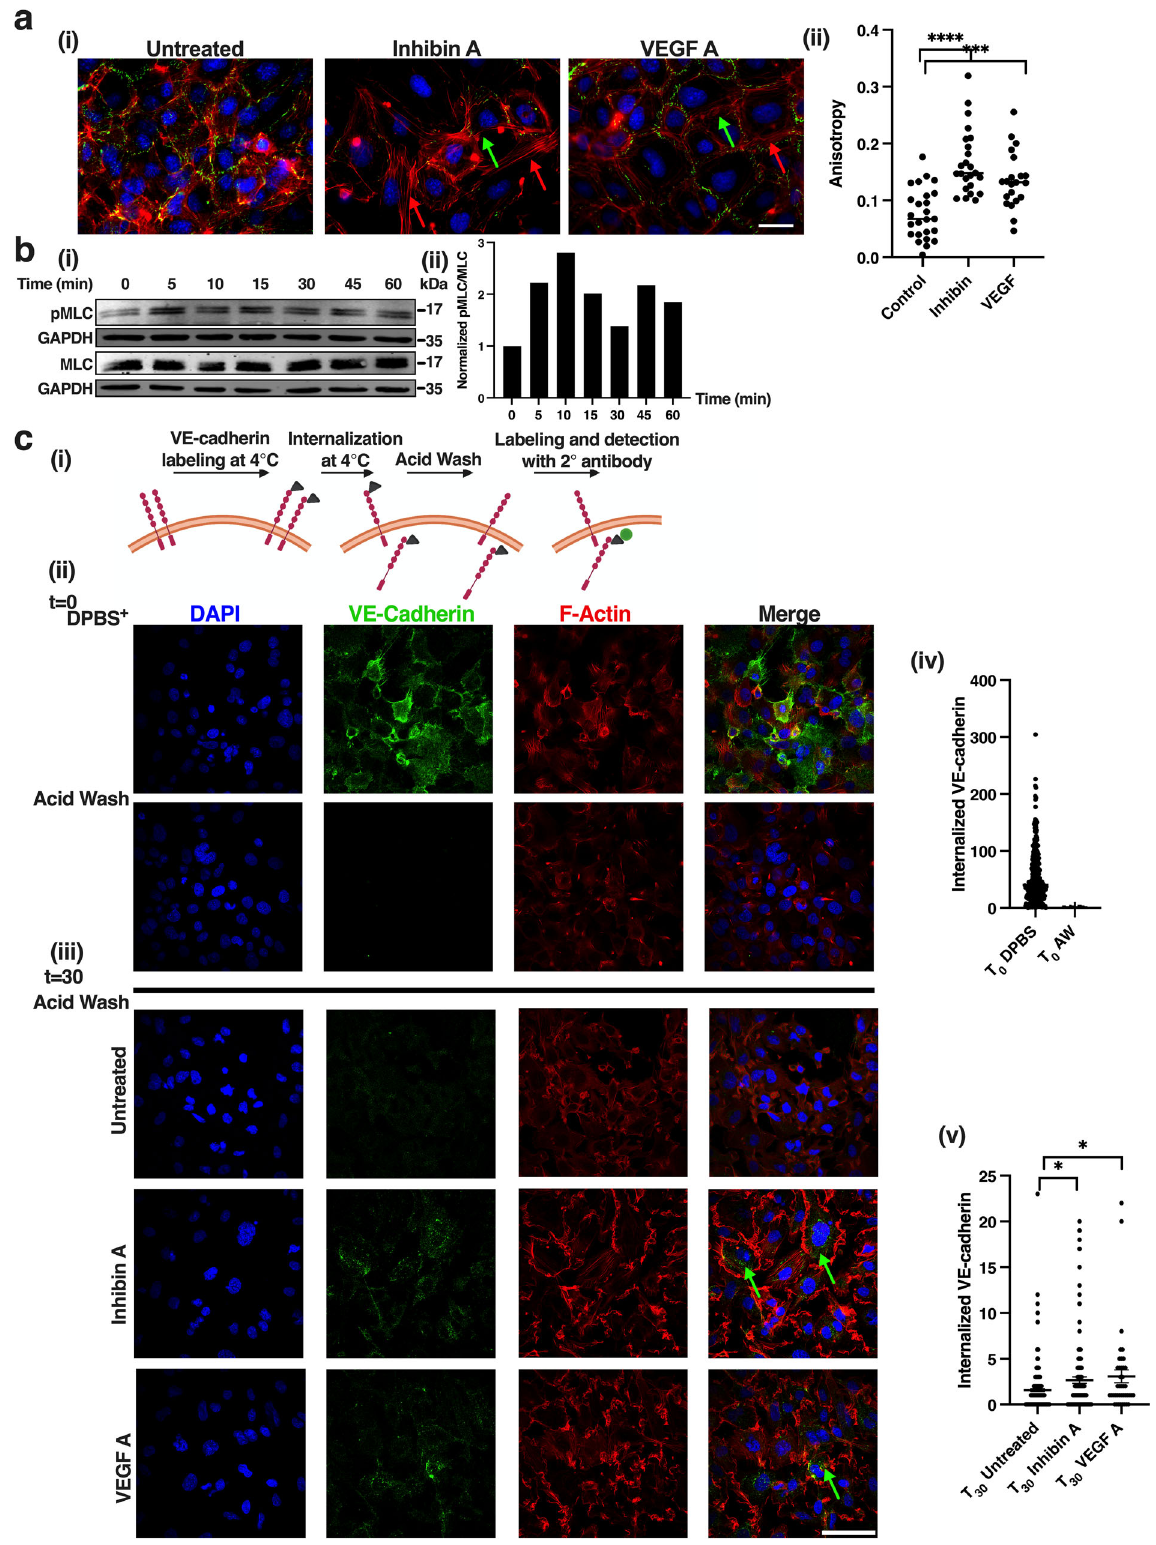
characteristic FRAP fl uorescence recovery time) reduces the mobile fraction ( R f ) of the Fab ’ -labeled receptor, since bleached Fab ’ -labeled receptors associated with immobilized receptors do not appreciably dissociate from the immobile patches during the FRAP measurement. On the other hand, transient complexes (short complex lifetimes) would reduce the apparent